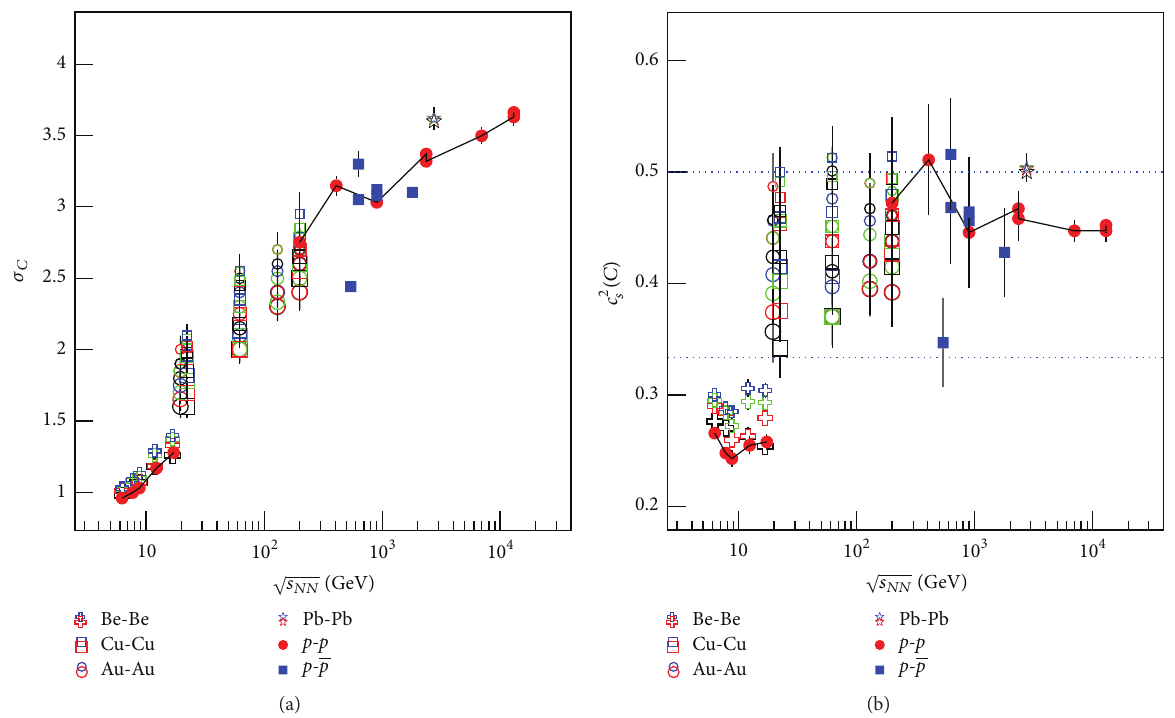
Figure 3: Dependences of (a) 𝜎 𝐶 and (b) 𝑐 2 𝑠 (𝐶) on √𝑠 𝑁𝑁 . The symbols represent the values listed in Table 1 (for the energy range ≤ 17.3 GeV), or taken from our previous work [25, 26] (for the energy range ≥ 19.6 GeV). The line segments for 𝑝 - 𝑝 collisions at SPS and higher energies are given for guiding the eyes, and the two dotted lines in (b) show 𝑐 2 𝑠 (𝐶) = 1/3 and 1/2, respectively. We would like to point out that we distinguish different objects by shapes not colors. The black and green objects have the same meanings as those of red and blue ones.